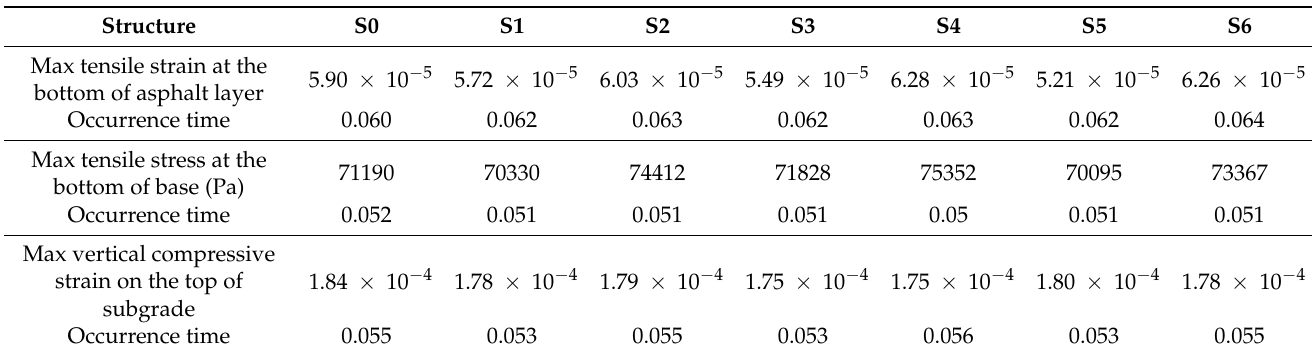
Table 6. Summary of maximum indicators and their occurrence